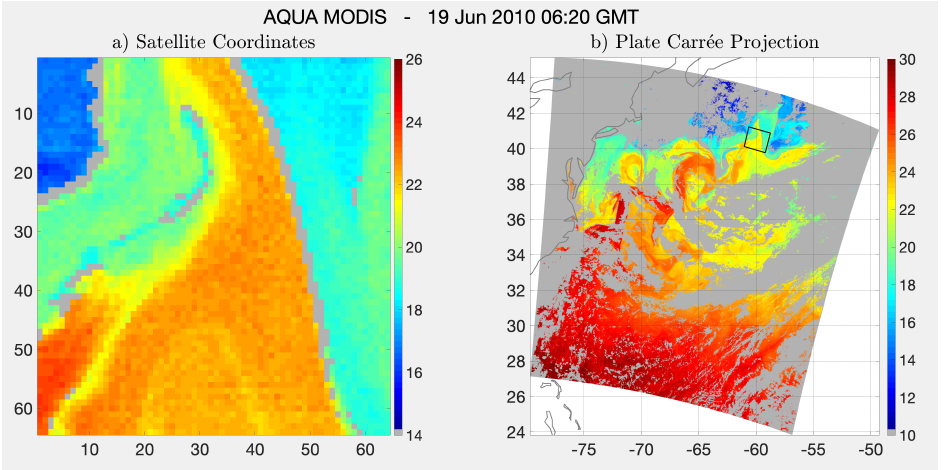
Figure 8. The 19 June 2010 cutout of Figure 7 with LL = − 1234.1, in the lowest 0.1% of the log- likelihood values for the dataset. ( a ) The original cutout in satellite-coordinates prior to preprocessing. ( b ) The entire granule shown in a plate carrée projection with the continental boundary (dark gray) and the cutout (black rectangle). Note the change of palettes from ( a ) to ( b ) to accommodate the larger range of sea surface temperature (SST) in ( b ). Light gray are masked pixels, from clouds, land or clear pixels improperly flagged as cloud-contaminated (Section